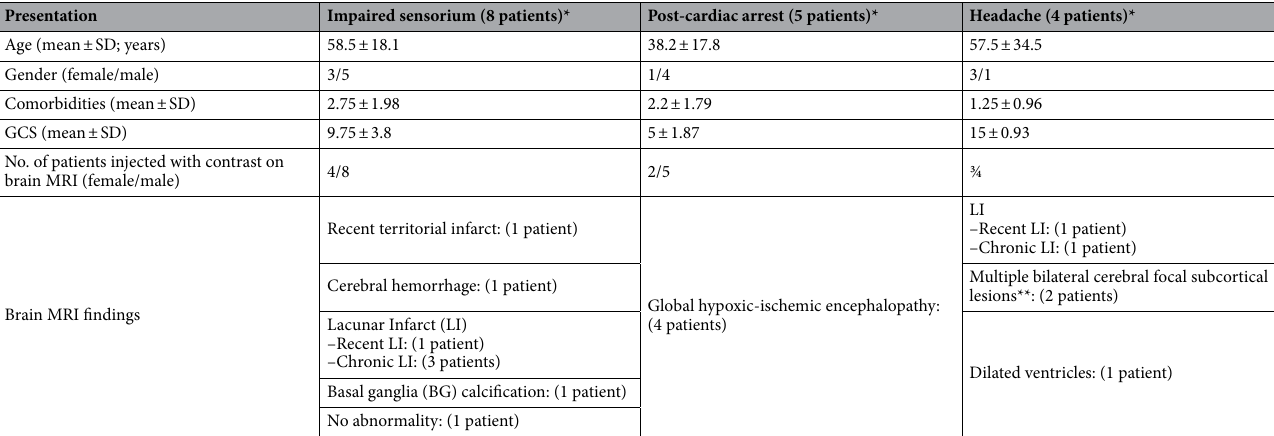
Table 2. Brain MRI findings in 17 patients, admitted with RT-PCR proved SARS-CoV-2 pneumonia, and presented with non-focal neurological manifestations. *Numbers in parentheses represents the number of patients within each subgroup. **Details in Table 4 and Fig. 6.